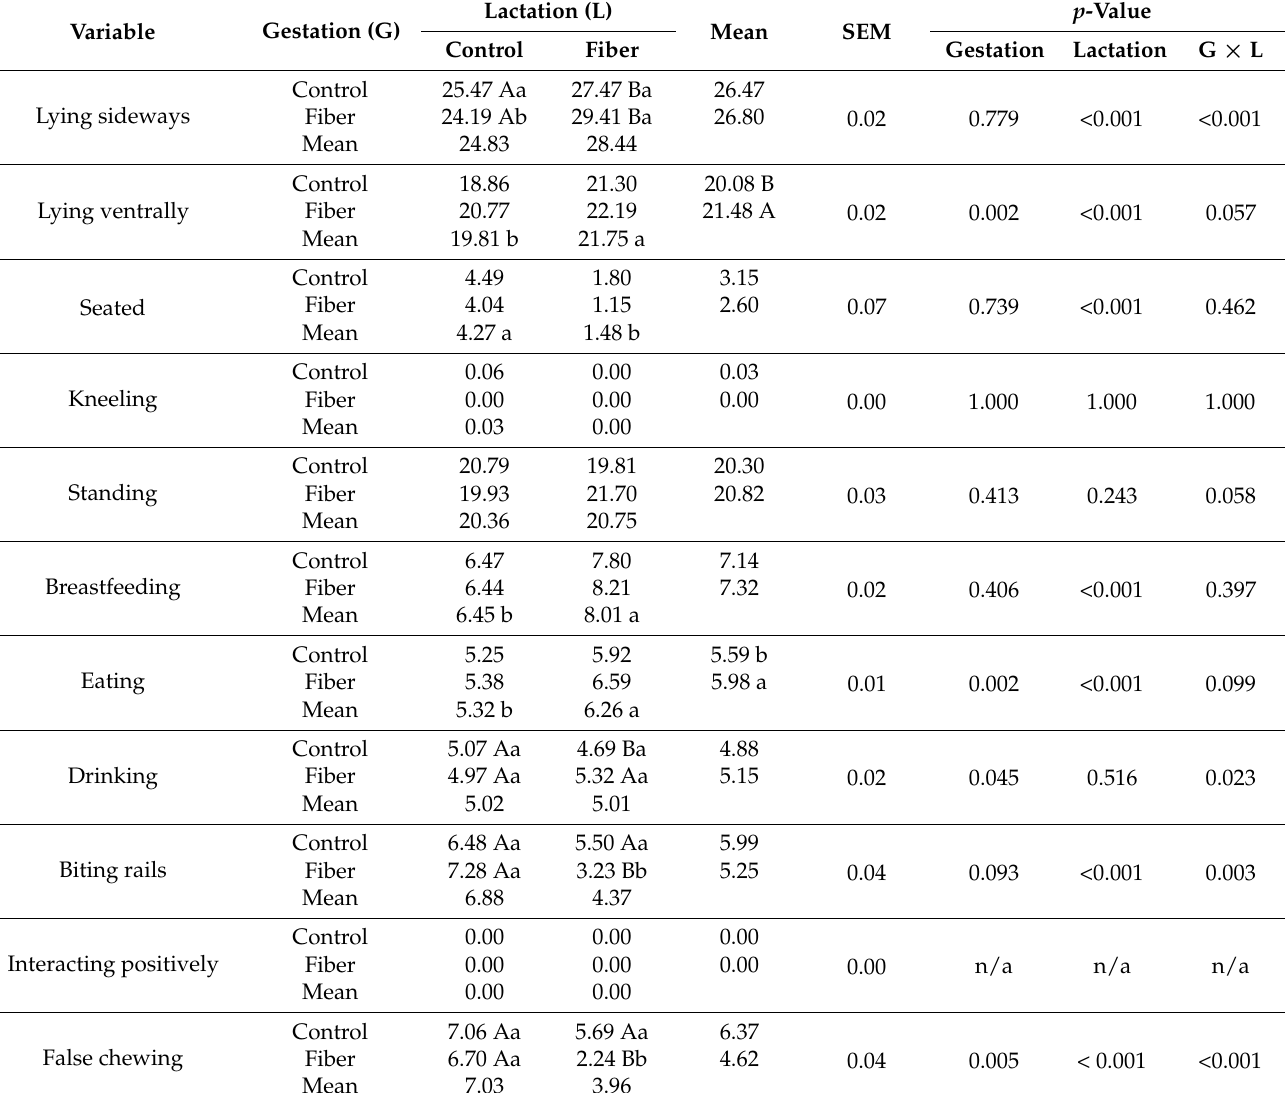
Table 10. Behavioral frequency (%) of sows during the stay in farrowing units (seven days before farrowing to weaning) supplemented or not with dietary fiber during gestation and